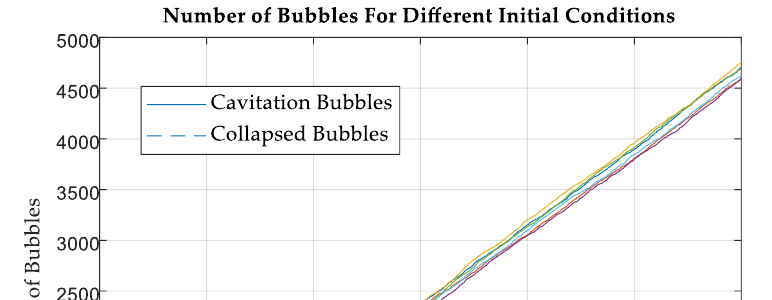
Table 4. Simulation 4: constants and coefficients.